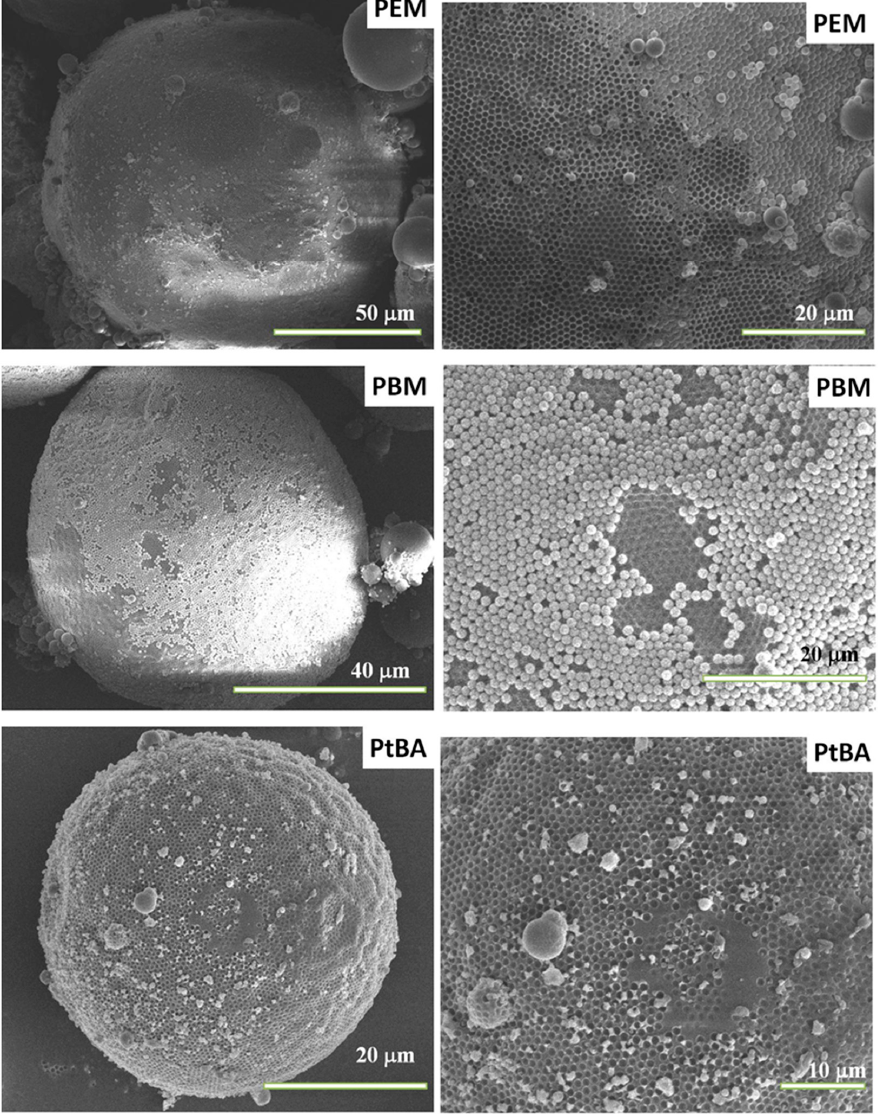
Figure 2. SEM images of the microspheres obtained after the polymerization of the Pickering emulsions of EM, BM and tBA in water, and the corresponding circular traces left by the stabilizing NP-L after Pickering emulsion polymerization.